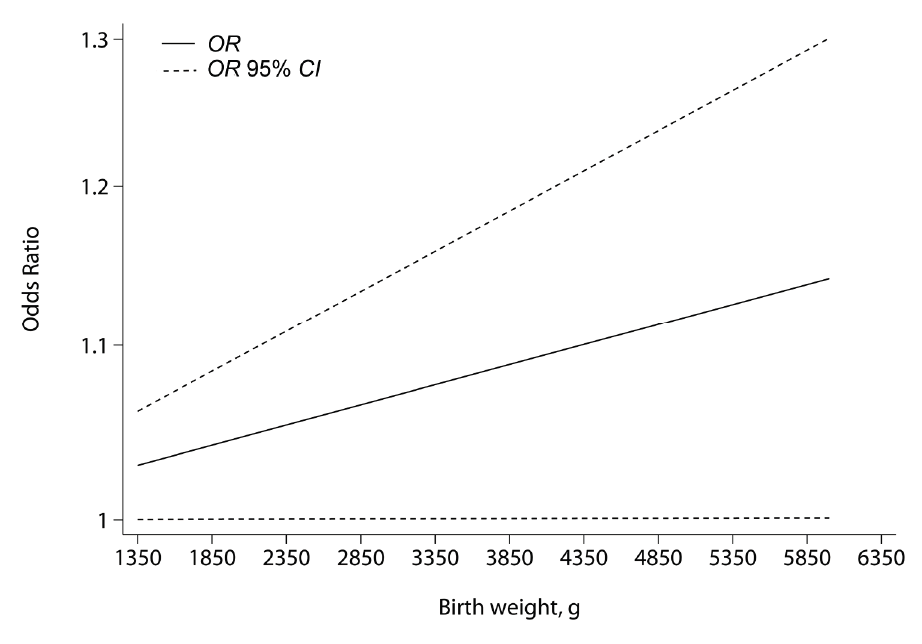
Figure 3. Results of dose-response analysis. The dotted lines denote the point-wise 95% CIs , while the solid line corresponds to ORs for the linear